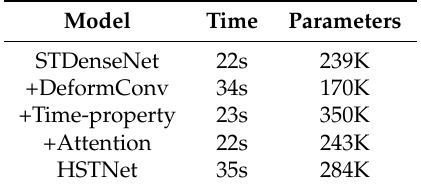
Table 2. The effects on parameters and the time of each